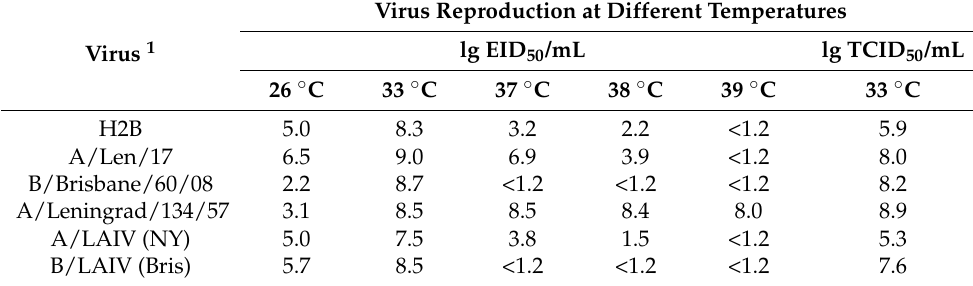
Table 1. Growth characteristics of studied viruses at different temperatures.